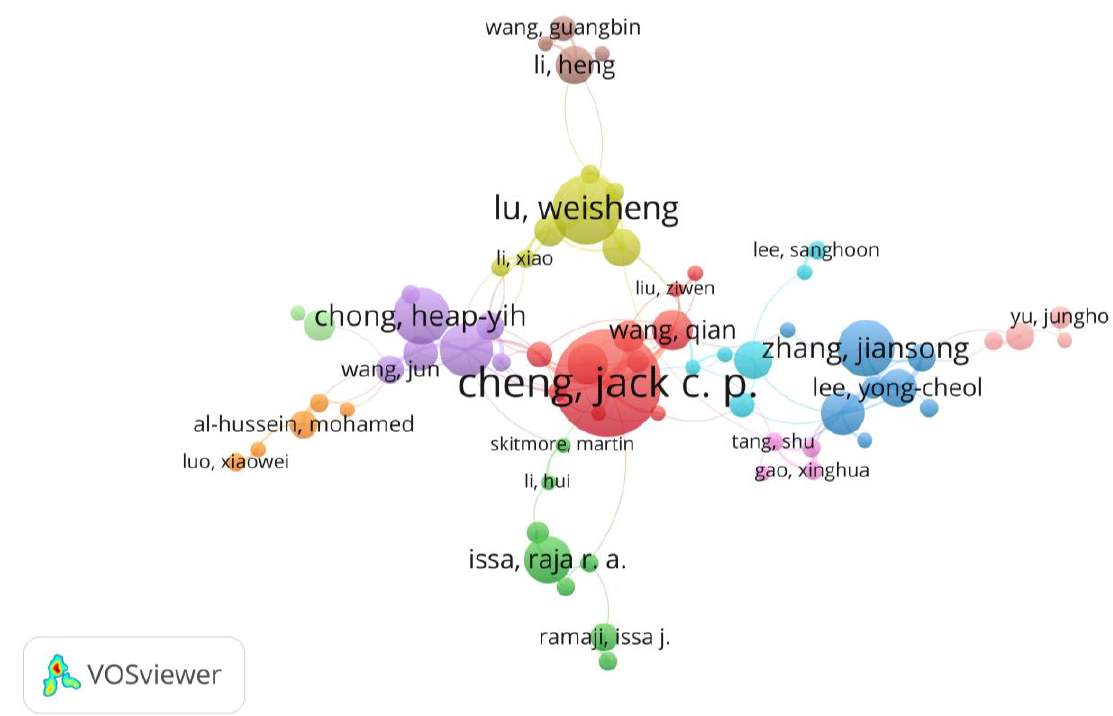
Figure 7. The network of cooperation considering